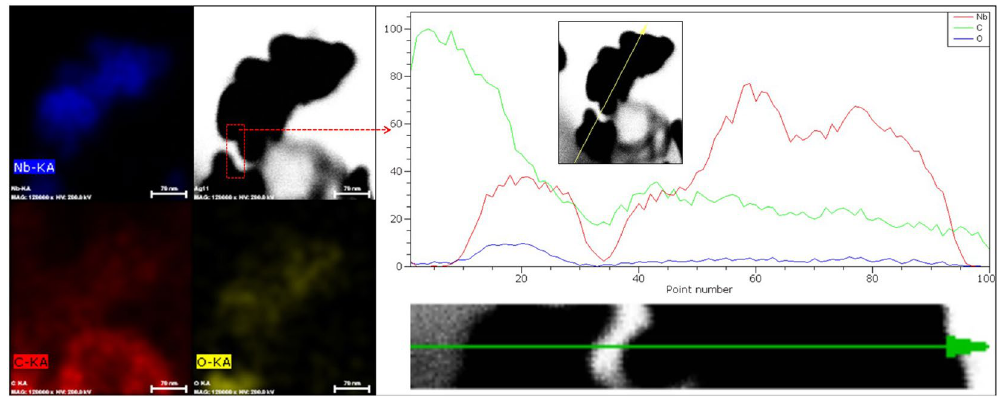
Figure 4. Elemental line profile of NbC nanoparticle (10C800) showing the concentration profile (Nb, C and O) across the shown nanoparticles (marked with green arrow). Elemental line profile suggests the homogenous distribution of oxygen inside the NbC nanoparticles while, smaller agglomerate contain higher O content than larger